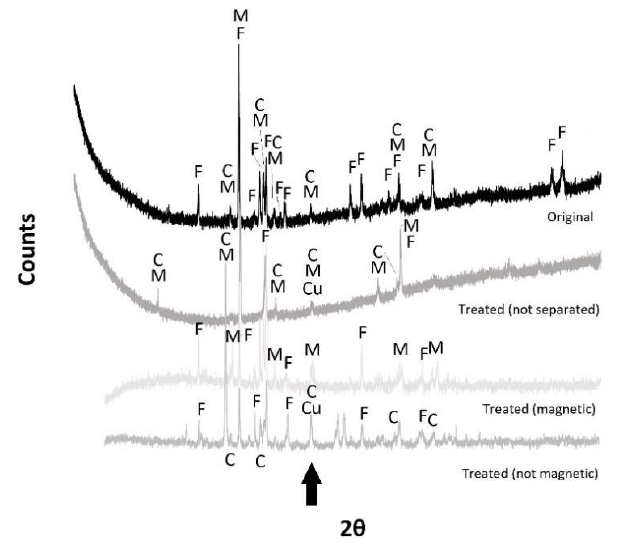
Figure 13. Specimen CuCon2 (C, CuFe 2 O 4 ; F, Fe 2 SiO 4 ; M, Fe 3 O 4 and all the iron spinel; Cu, metallic copper).